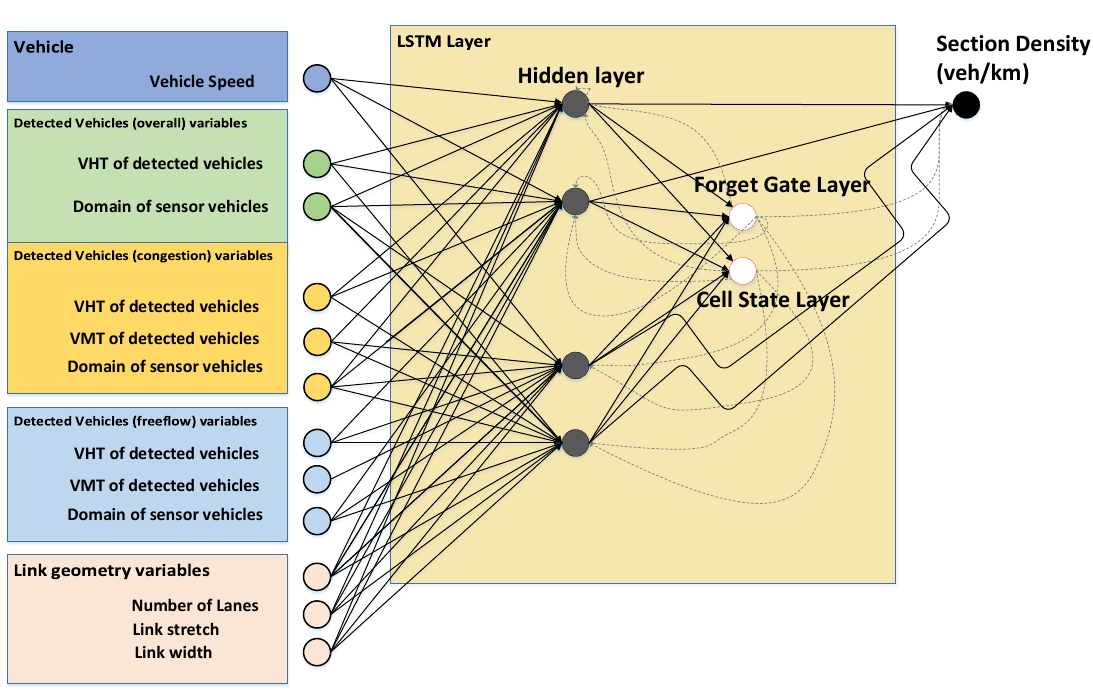
Figure 4. Input-output variables and LSTM network design.